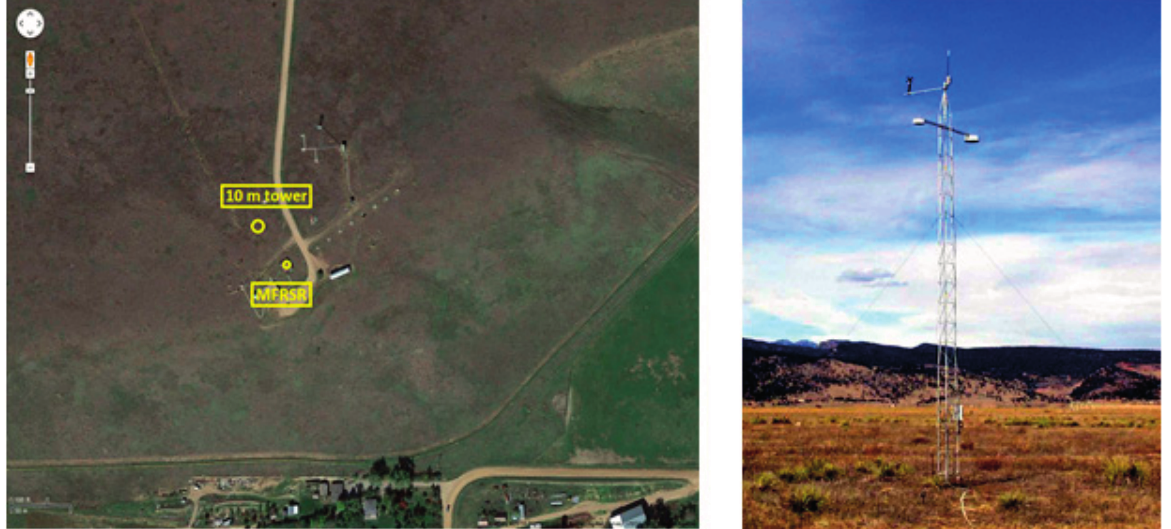
Figure 2. Aerial image of the National Oceanic and Atmospheric Administration (NOAA) site ( left , taken from Google maps on 7 May 2014) and ground-based image of the 10-m tower ( right , from http://www.esrl.noaa.gov/gmd/grad/surfrad/tablemt.html). The image (about 1 × 1 km 2 ) illustrates that this tower is surrounded by several sub-areas with different surface types, including “brown” soil and “green”